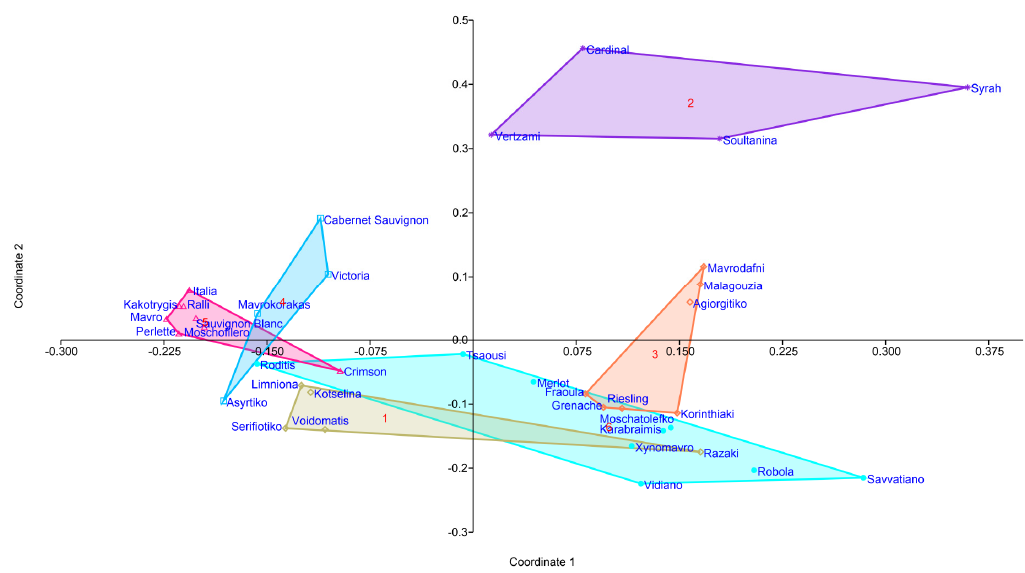
Figure 3. PCoA constructed using Bray–Curtis at the genus level for 37 grapevines. 9